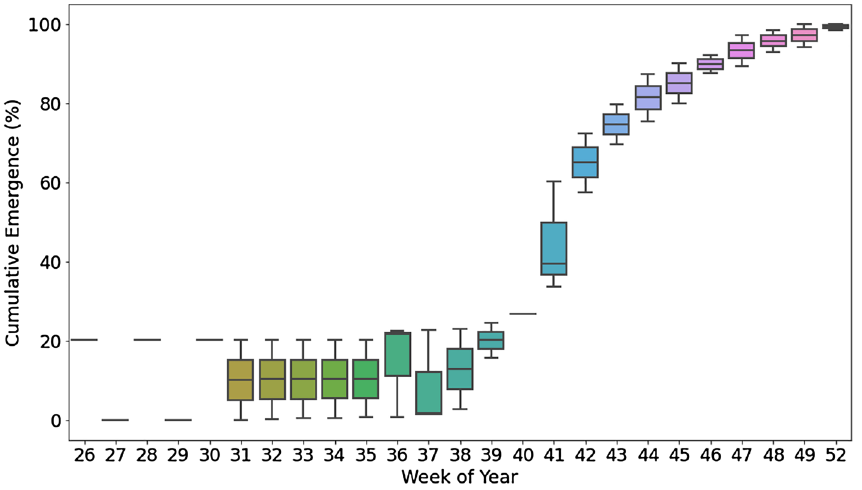
Figure 3. Weekly changes in P. annua emergence during 2019 and 2020 at three locations in East Tennessee: East Tennessee AgResearch & Education Center—Plant Sciences Unit (Knoxville, TN; 35.90°N, -83.95°W), Lambert Acres Golf Course (Alcoa, TN; 35.75°N, − 83.88°W), Three Ridges Golf Course (Knoxville, TN; 36.09°N, − 83.84°W). Boxes represent 25, 50, and 75% percentiles with minimum and maximum values represented by vertical